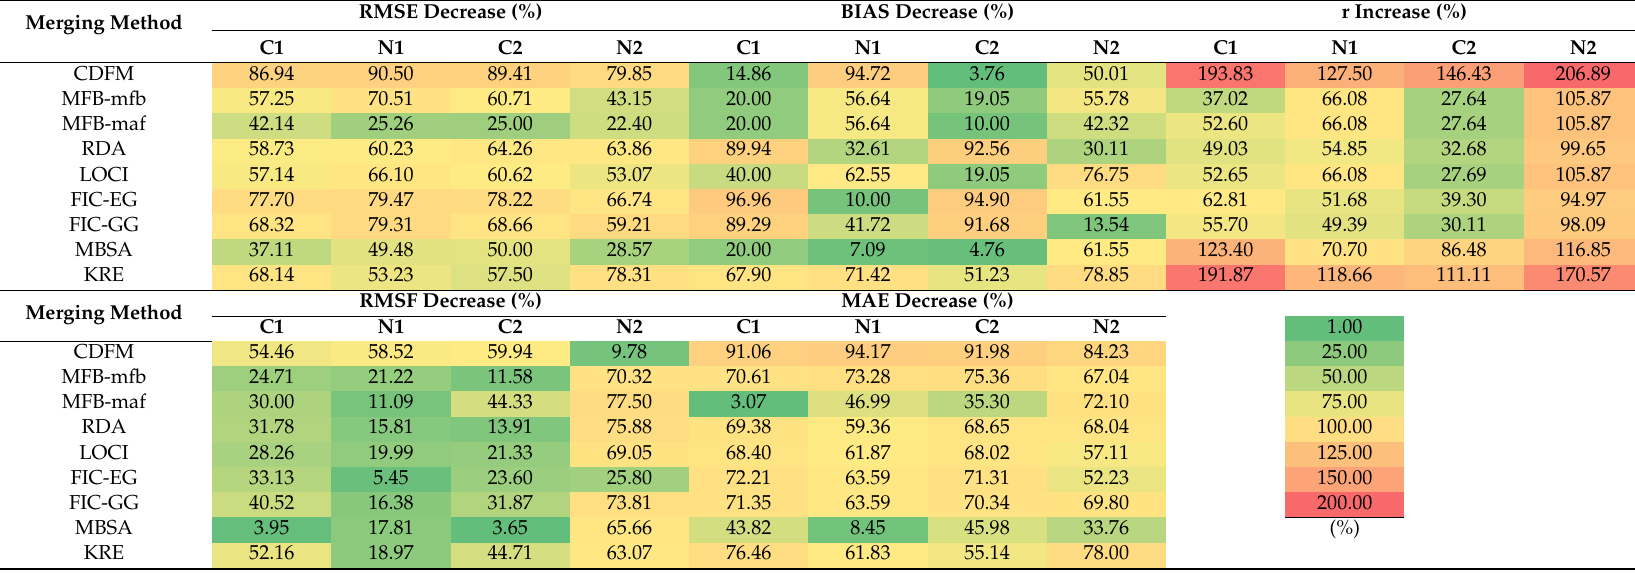
Table 3. Percentage of change of RMSE, BIAS, Correlation, RMSF, and MAE after application of radar-gauge merging methods. Merging